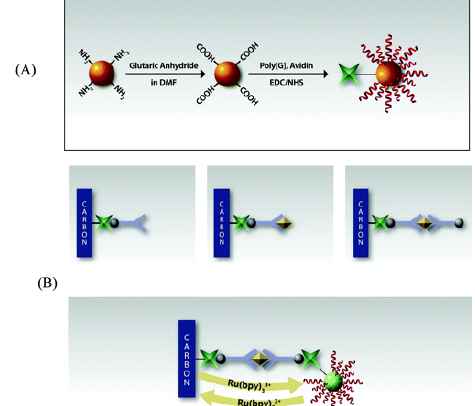
Figure 12. Schematic illustrations of ( A ) the procedure for preparation of poly[G]- and avidin- functionalized SiNP conjugate and ( B ) the procedure and principle for electrochemical immunoassay. Sandwich immunoreaction of TNFα with Ab 1 and Ab 2 brings poly[G] close to the electrode, which undergoes oxidation, mediated by Ru(bpy) 32+ . Reprinted from [145] with permission from American Chemical Society.